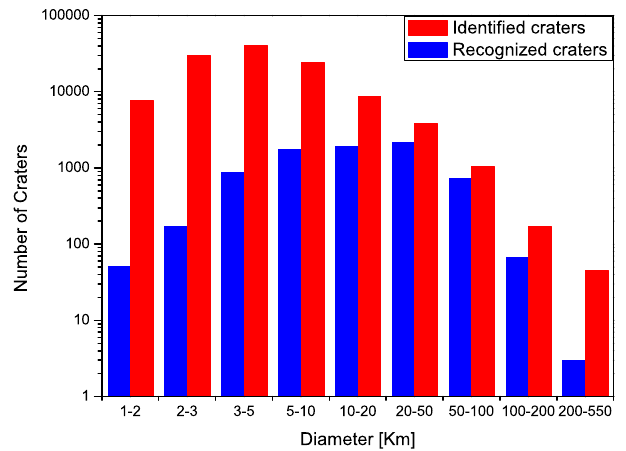
Fig. 3 Identi fi ed lunar impact craters distributions compared with the recognized craters from the International Astronomical Union (IAU) in different diameter scales. The red column represents the number of the identi fi ed craters compared with the number of the recognized craters (blue column). Recognized craters used for identi fi cation are the ones completely located within the study area having diameters larger than 1 km and smaller than 500 km. Source data are provided as a source data fi le.